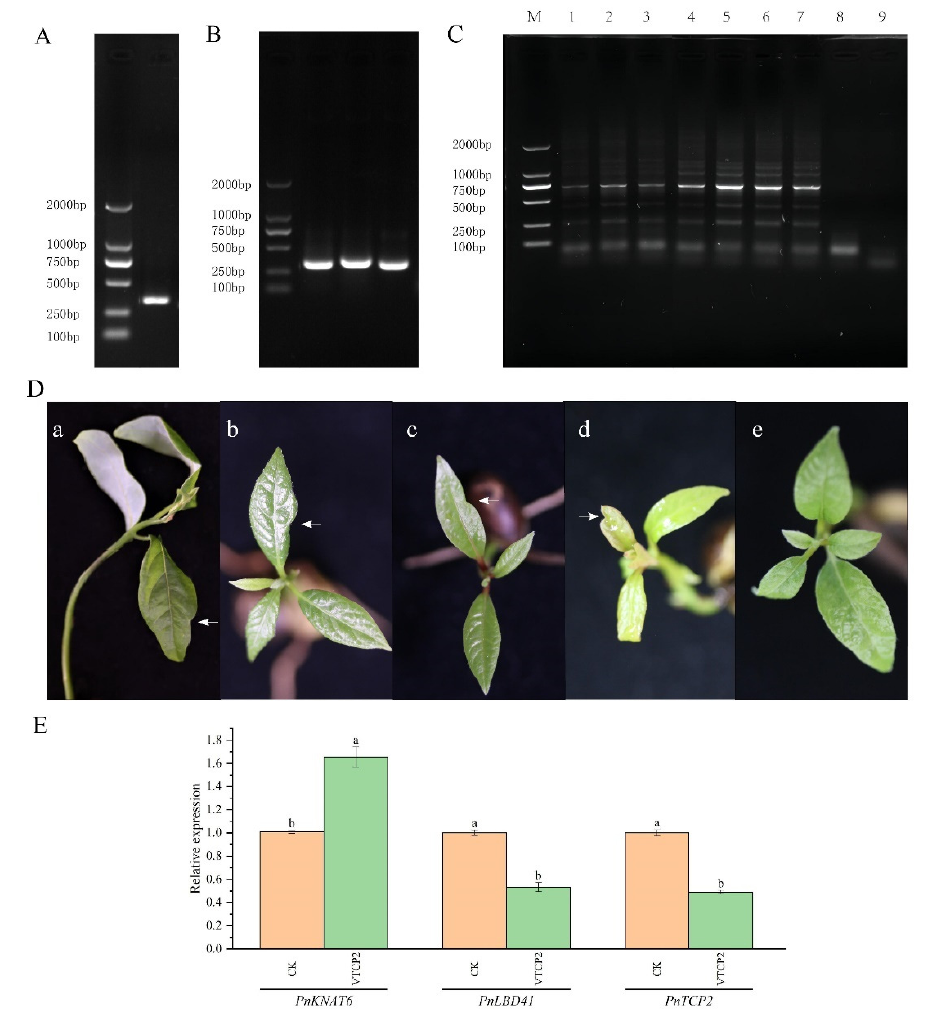
Figure 4. TVR-VIGS gene silencing function verification of PnTCP2 . ( A ) Electrophoresis of VTCP2 fragments. ( B ) PCR identification of positive clones. ( C ) Test electrophoresis diagram of TRV-VIGS- positive plants. ( D ) Lobed leaf phenotype after PnTCP2 VIGS gene silencing. The position pointed out by the white arrow is the lobed part of the blade. ( E ) Expression analysis of related genes in pTRV2- VTCP2 seedlings. The standard deviation (SD) was used to measure the error within a group, and the Tukey method was used to compare the significance between samples at p < 0.05. Note: ( C ) M, the 2000 pb DNA marker; (1, 2 and 3) control bands, (4–7) pTRV2- VTCP2 plant bands, (8,9) bands of plants without TVR-VIGS treatment. ( a – d ) The pTRV2- VTCP2 gene-silenced seedlings of P. neurantha. ( e ) The control treatment seedlings of P. neurantha . ( E ) Different lowercase letters indicate significant differences between the two groups ( p < 0.05).